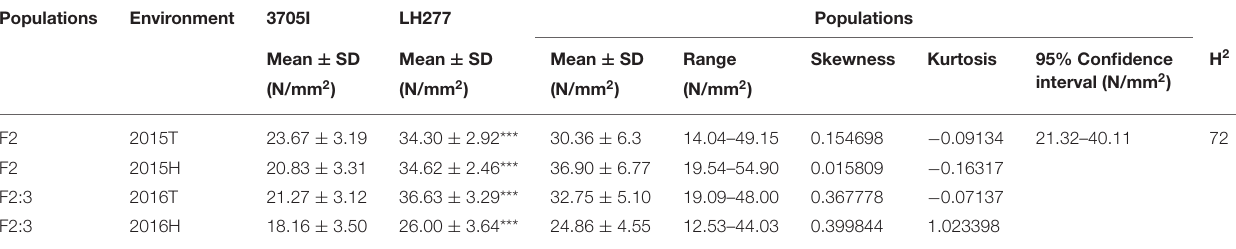
TABLE 1 | Phenotypic performance and broad-sense heritability for RPR in F 2 and F 2 : 3 populations.